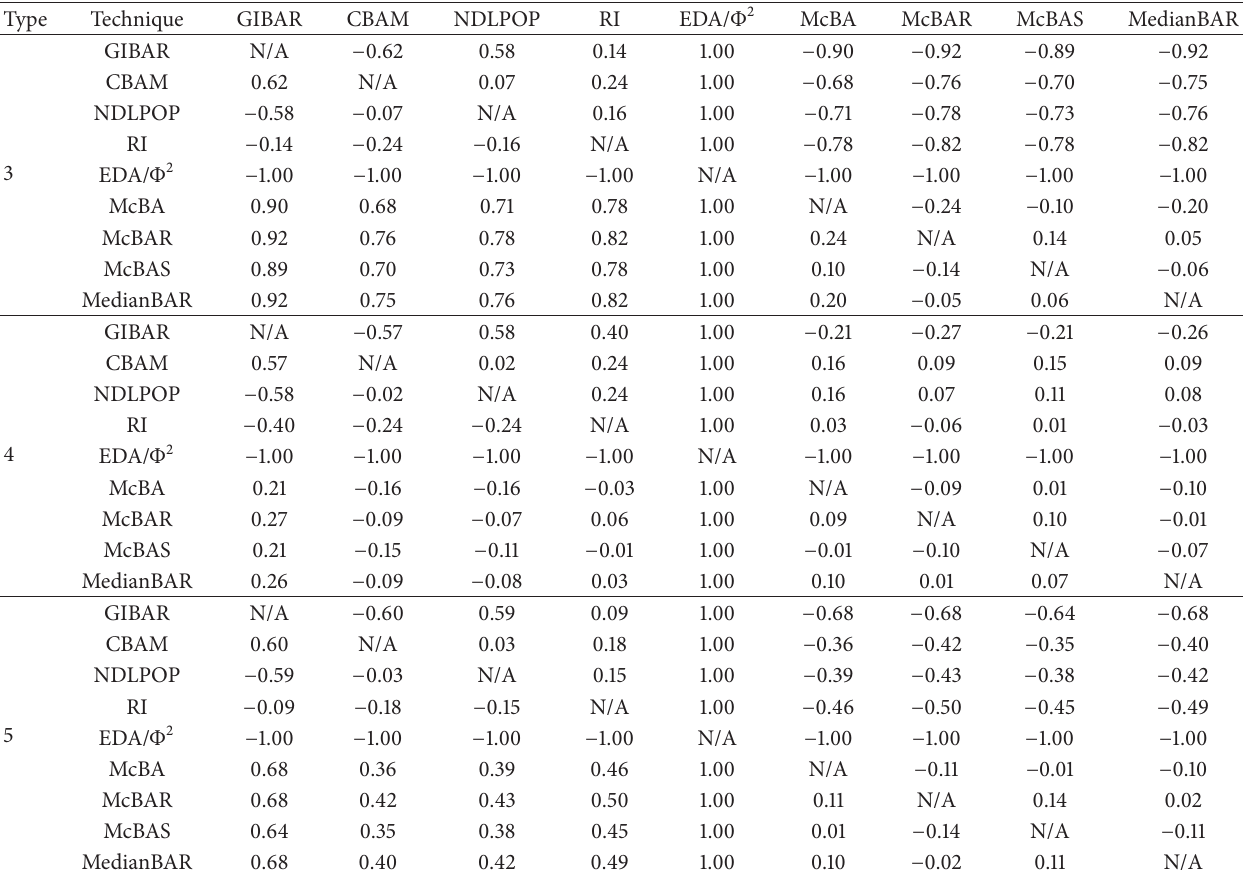
Table 10: Average E 𝜏 𝑡 [⋅] performance under change types 3 to 5.